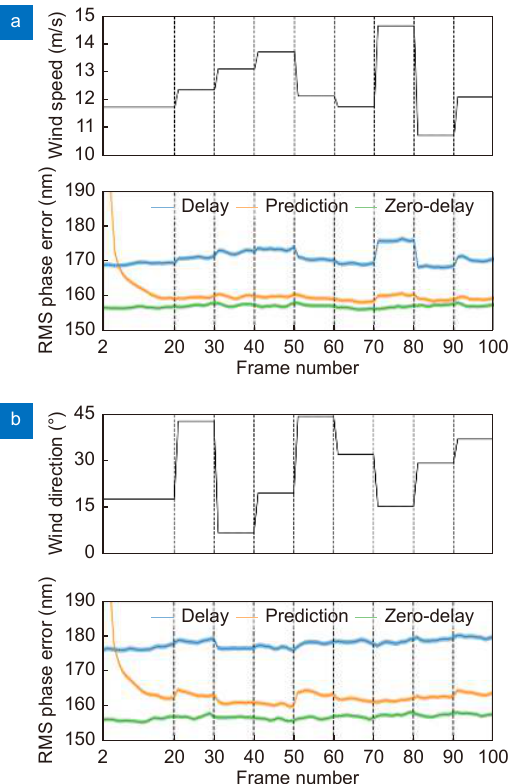
Fig. 15 | ( a ) Robustness of the predictor against wind speed fluctu- ations between 10 and 15 m/s every 10 frames. ( b ) Robustness of the predictor against wind direction fluctuations between 0 and 45 degrees every 10 frames. Figure reproduced from: (a, b) ref. 91 , Ox- ford University